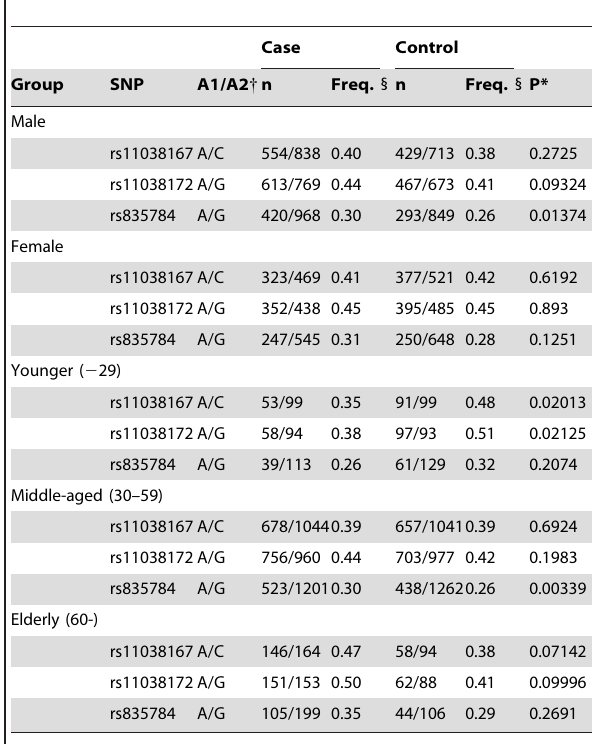
Table 2. Association study of three SNPs in TSPAN18 under different models.